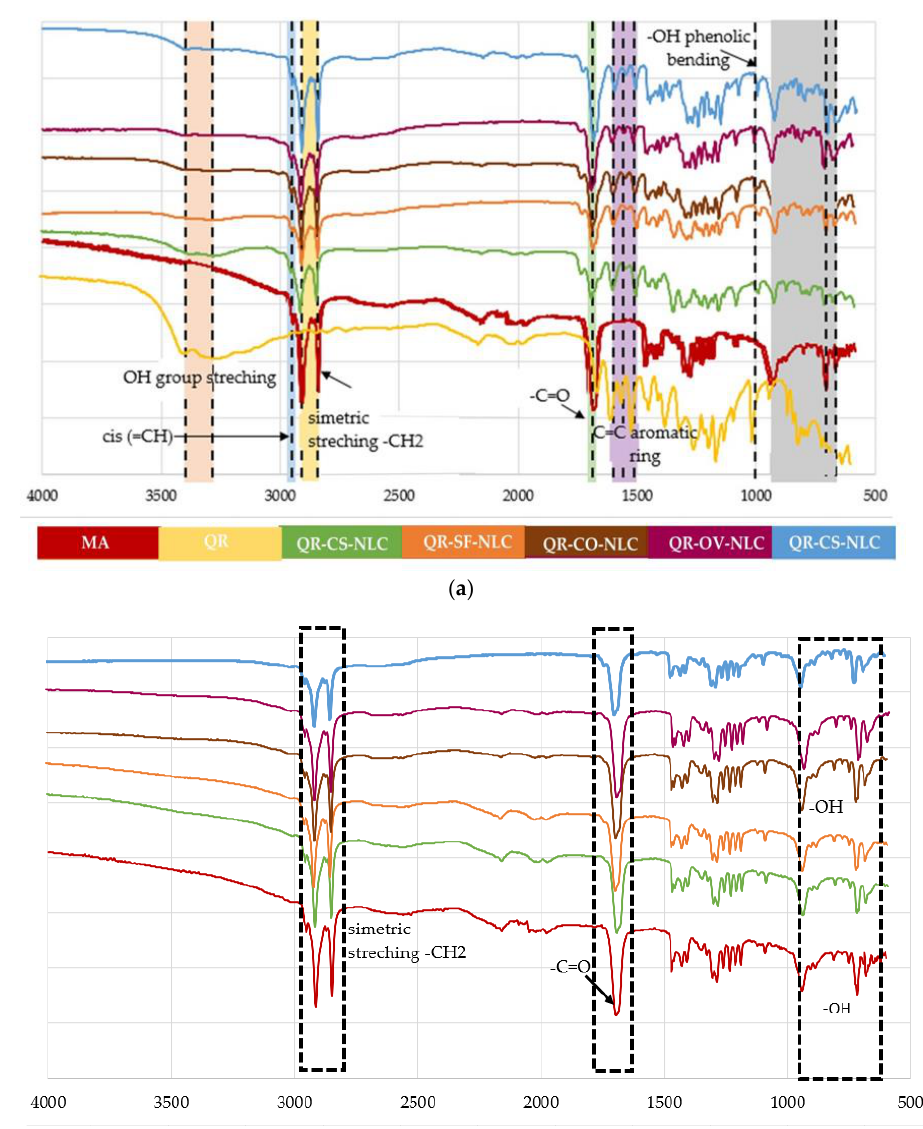
Figure 4. FTIR spectra of QR-NPO-NLCs. FTIR analysis of ( a ) QR-NPO-NLC, ( b ) NPO-NLC.